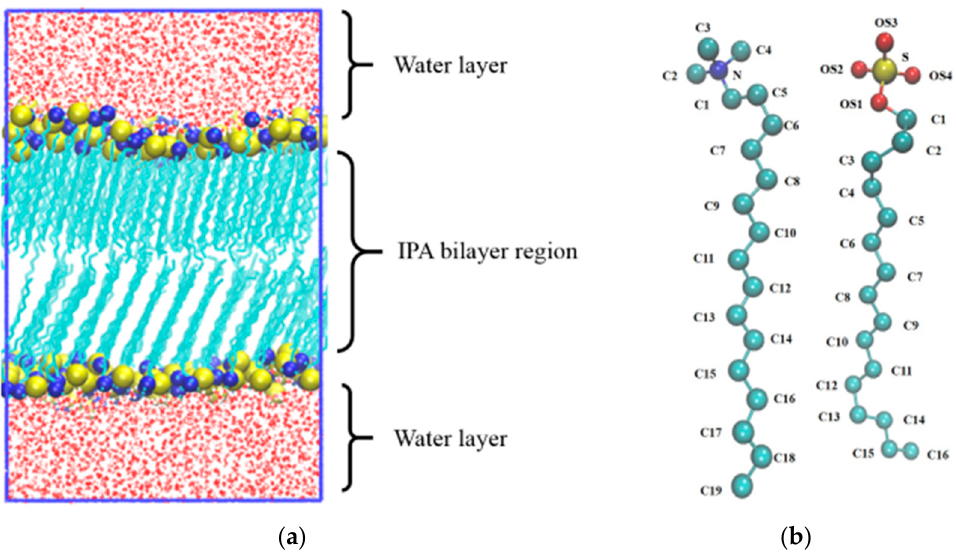
Figure 1. ( a ) A representative initial configuration of the biomimetic ion pair amphiphile bilayer systems for molecular dynamics (MD) simulation. The presented ion pair amphiphile (IPA) bilayer is composed of hexadecyltrimethyl-ammonium-dodecylsulfate (HTMA-HS) IPA, i.e., C 16 TMA + -C 16 S − . ( b ) The molecular structure of HTMA-HS IPA. Atomic color codes are: nitrogen in blue, sulfur in yellow, oxygen in red, and carbon in turquoise, respectively. Hydrogen atoms are not shown for clarity. Graphics were made using VMD [24].